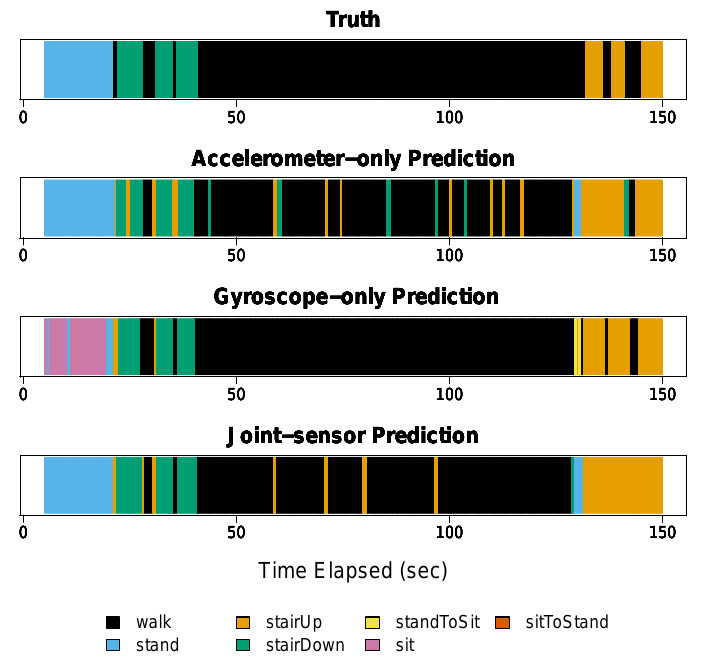
Figure 9. Step 1 for participant 1. The figure shows the results for participant 1 during step 1.